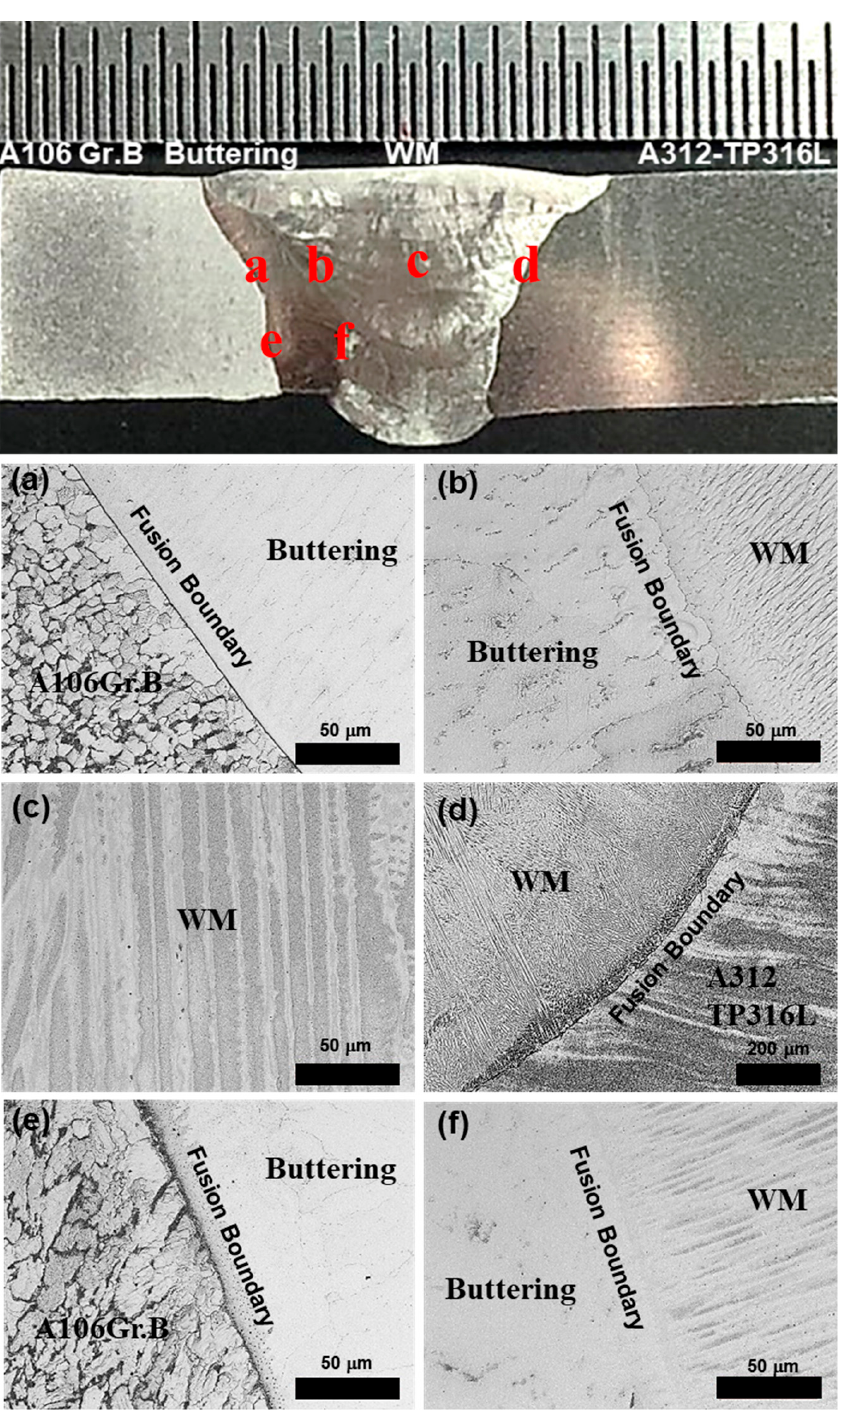
Figure 2. Optical micrographs of the dissimilar welds: middle part of ( a ) A106Gr.B (base metal, BM) and buttering; ( b ) buttering and weld metal (WM); ( c ) weld metal (WM); ( d ) weld metal (WM) and A312 TP316L (BM); bottom part of ( e ) A106Gr.B (BM) and buttering; ( f ) buttering and weld metal (WM).